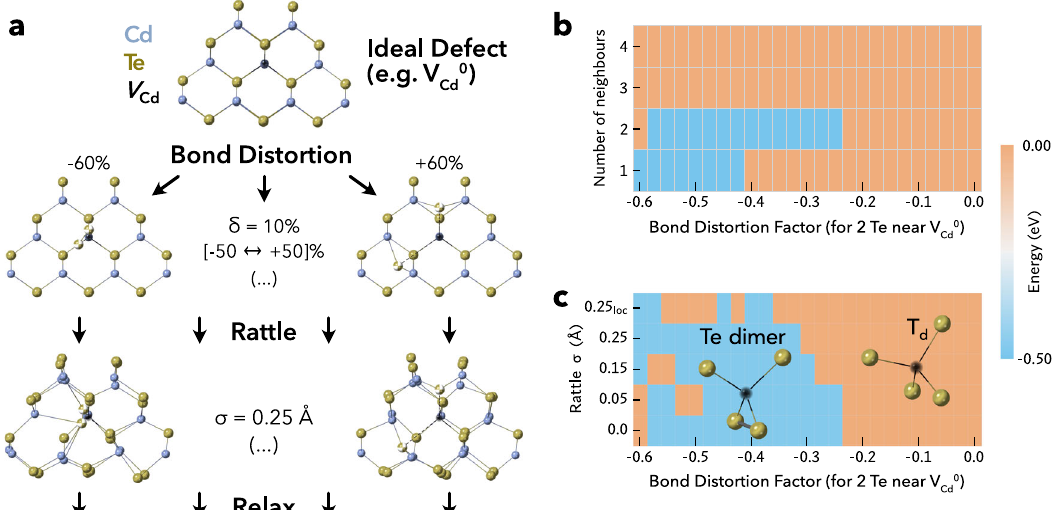
Fig. 2 Schematic representation of our approach, as described in the Methods section, using the neutral cadmium vacancy ( V 0 as an example. a Structure generation method, with bond distortion and rattle steps. Cd in blue, Te in gold and V Cd in black, with the distorted Te neighbours shown in a gold/white. b Relative energy of relaxed structures for V 0 neighbours and c rattle standard deviations. A localised rattle (where only atoms within 5 Å to the defect are distorted) is also shown ( σ = 0.25 loc Å ). The widest interval of bond distortions leading to the ground state is obtained by distorting two nearest neighbours. Only negative bond distortions are shown since all positive ones yield the metastable `Tetrahedral' con fi